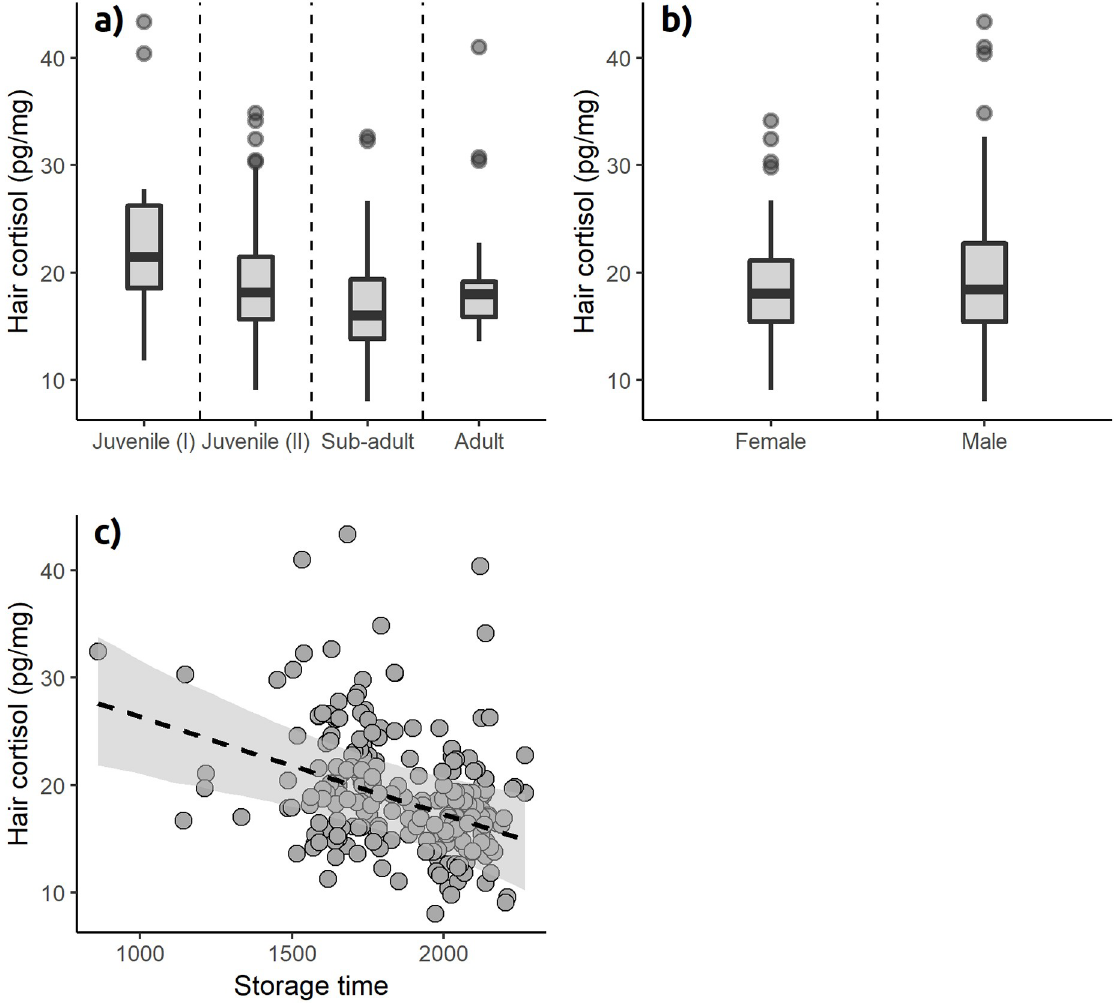
Fig 2. Variation in hair cortisol (pg/mg) in the Egyptian mongoose with a) age, b) sex, and c) storage time of hair samples (days). Hair cortisol concentration was higher in first stage juveniles than other age groups. Hair samples from males had higher cortisol concentration than females. Cortisol concentration was lower in hair samples stored for more